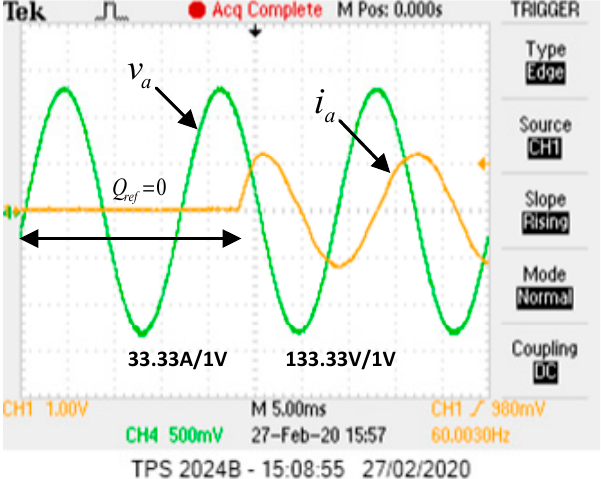
Figure 12. Voltage and current for phase A during Qref = 0 to Qref = 10kVAr and Pref = 0.